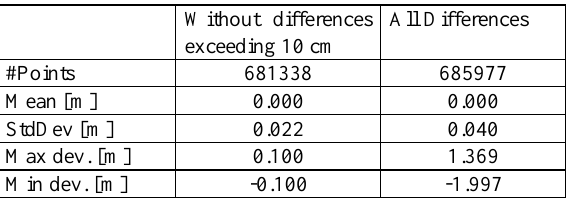
Table 1. Statistics of differences between UAS and TLS over